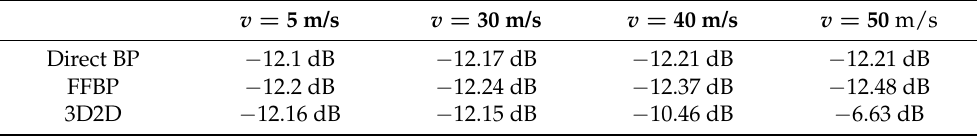
where P total is the total power of the IRF, while P main is the power inside the main lobe. The figure of merit confirms what is already clear: the 3D2D algorithm worsens for long apertures, reaching unacceptable values of ISLR for speed between 40 and 50 m/s. Table 3. ISLR for different velocities (aperture length) and for different focusing